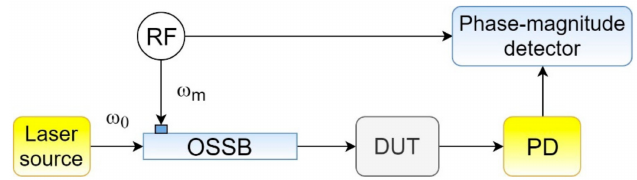
Figure 1. Block diagram of the optical vector analyzer (OVA) based on optical single-sideband (OSSB)-modulation: RF—radio frequency; OSSB—OSSB modulator; DUT—device under test; PD—photodetector (adapted from